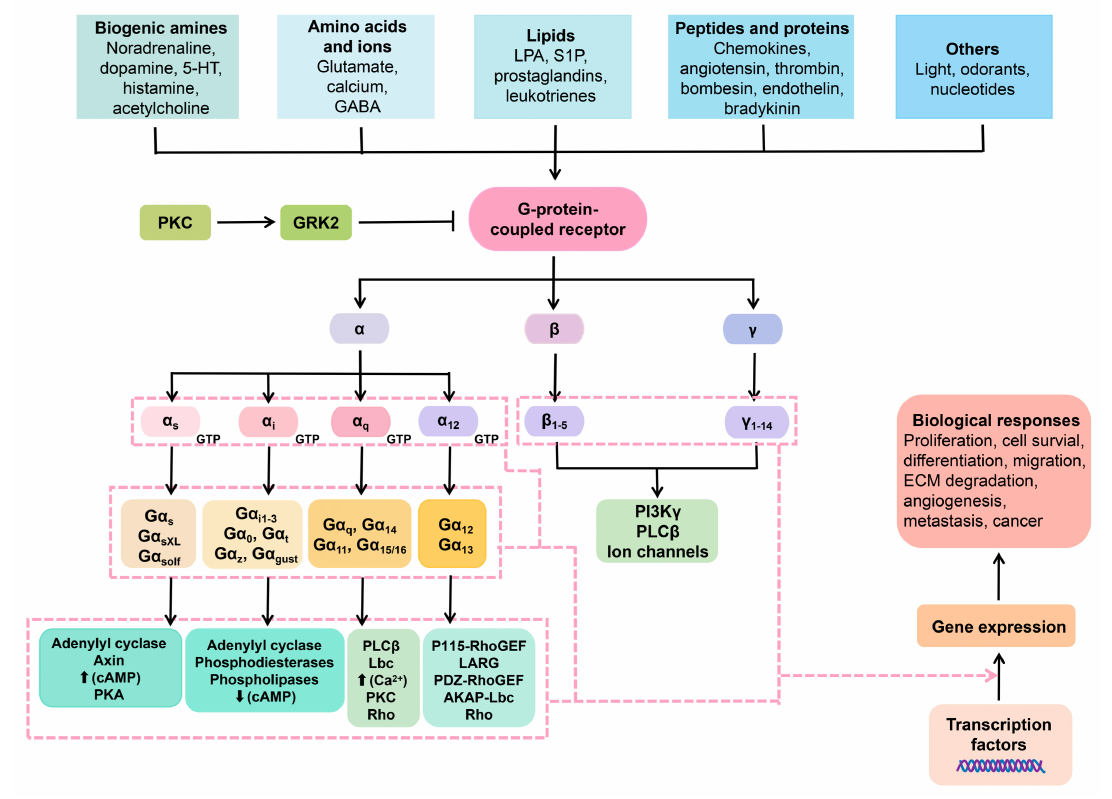
Figure 2. Membrane GPCRs and the intracellular cascade pathways in relation to neuropharmacy. Ligands interact with the extracellular GPCRs. The GPCRs are harnessed to heterotrimeric protein units, namely the α , β , and γ . Once the GCPRs perceive the ligands (ions, lipids, proteins, and so on), the heterotrimeric protein disengage in a manner that the α subunit exchanges GDP for GTP, hence activation. Once that occurs, a number of signal transduction pathways can take